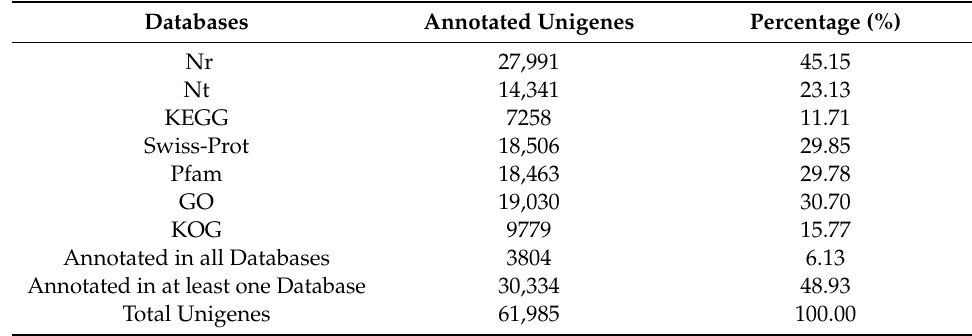
Table 1. The statistical analysis of the annotated